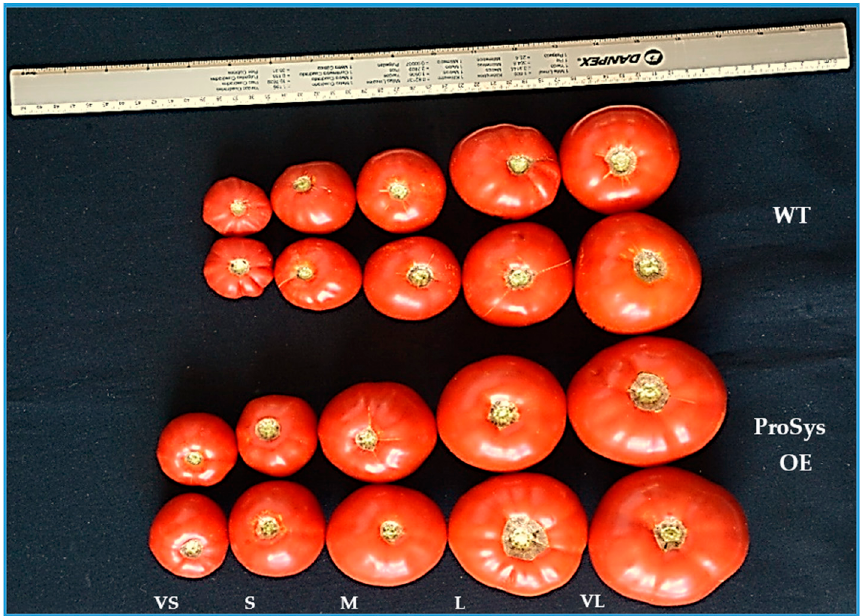
Figure 4. Increased size and weight of fruits produced by prosystemin overexpressing tomato plants. Compared to wild-type (WT) untransformed plants, the overexpression of the prosystemin (ProSys-OE) precursor protein of the systemin peptide hormone, led to the production of larger and heavier fruits. Shown in this image are five fruit sizes (very large (VL), large (L), medium (M), small (S) and very small (VS)) obtained from the second of a total of three harvest lots of WT and ProSys-OE tomato plants. Table 3. Physicochemical properties and reproductive traits of fruits harvested from wild-type (WT) and prosystemin overexpressing (ProSys-OE) plants. Fruits were obtained from WT untrans- formed tomato plants and from plants overexpressing the ProSys precursor protein of the sys- temin peptide hormone. Fruits from three different seasonal harvests and having different sizes were analyzed.